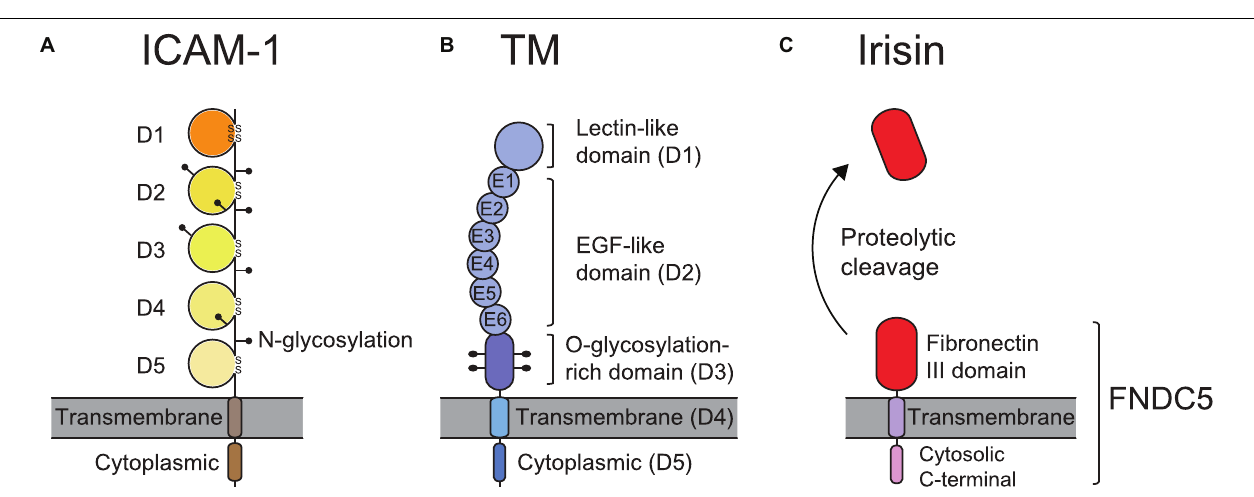
FIGURE 2 | ICAM-1, TM, and FNDC5 domains and structures. (A) ICAM-1 consists of 5 immunoglobulin (Ig)-like domains (D1 ∼ D5), a transmembrane domain, and a cytoplasmic domain and contains 8 N-linked glycosylation sites. The disulfide bonds in the Ig-like domains are formed between cysteine residues that stabilize the structure. (B) Thrombomodulin (TM) contains a lectin-like domain (D1), 6 epidermal growth factor (EGF)-like domains (D2), an O-glycosylation-rich domain (D3), a transmembrane domain (D4), and a cytoplasmic domain (D5). (C) Fibronectin type III domain-containing protein 5 (FNDC5) is composed of a fibronectin III domain (irisin), a transmembrane domain, and a cytosolic C-terminal domain. Irisin is produced by the proteolytic cleavage of